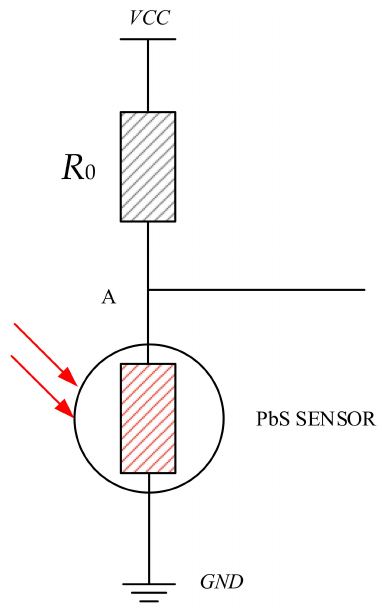
Figure 4. Photoelectric signal extraction